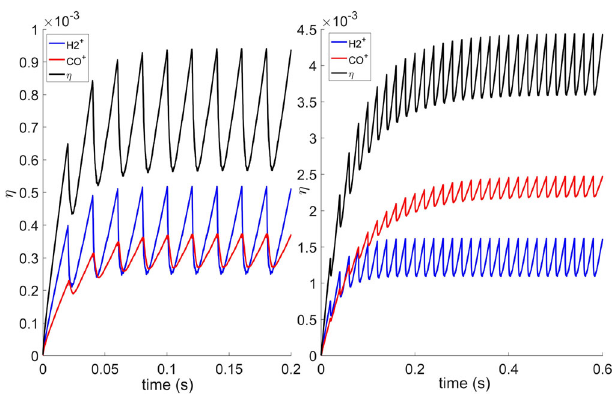
FIG. 10. The neutralization factor η vs time with clearing electrodes on the left and without clearing electrodes on the right. The contribution of CO þ ions to the neutralization factor is in red, the contribution of H þ 2 ions is in blue and the full neutralization factor is in black. The left plot shows 10 cycles of 20 ms of beam- ion interaction followed by a 4 μ s clearing gaps while the right plot shows 30 cycles. Initial residual gas mix: total pressure ¼ 3 × 10 − 10 mbar with 90% of H P t 2 and 10% of